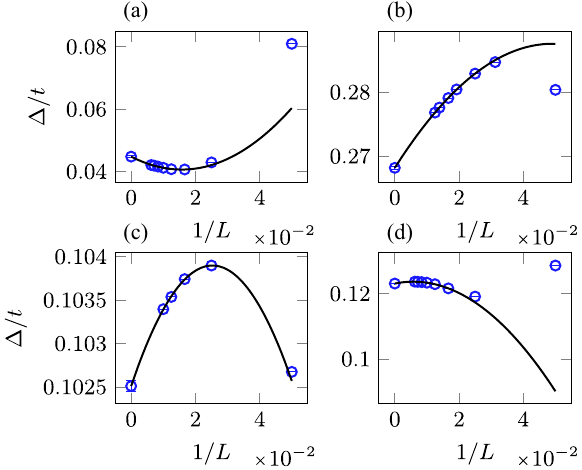
FIG. 14. Examples of finite-size extrapolations of the gap from the ground state to the first excited state ( Δ ) for (a) t ⊥ ¼ 0 . 05 t , and (d) t ⊥ ¼ 0 . 05 t , U ¼ − 2 t . All data at n ¼ 0 . 5